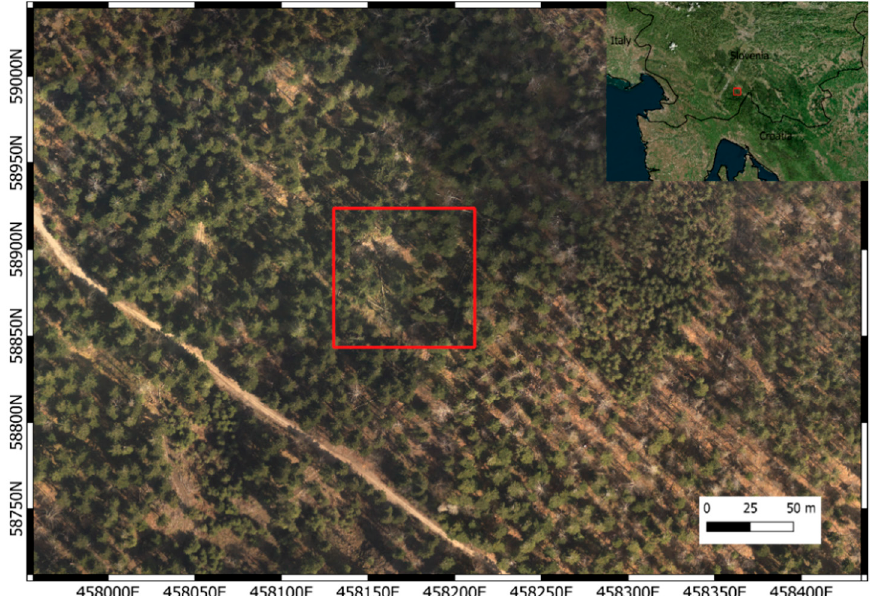
Figure 1. The study area location (Dinaric Mountains, Southwest Slovenia) The red box defines the area covered by laser scans. EPSG: 3912. area covered by laser scans. EPSG: